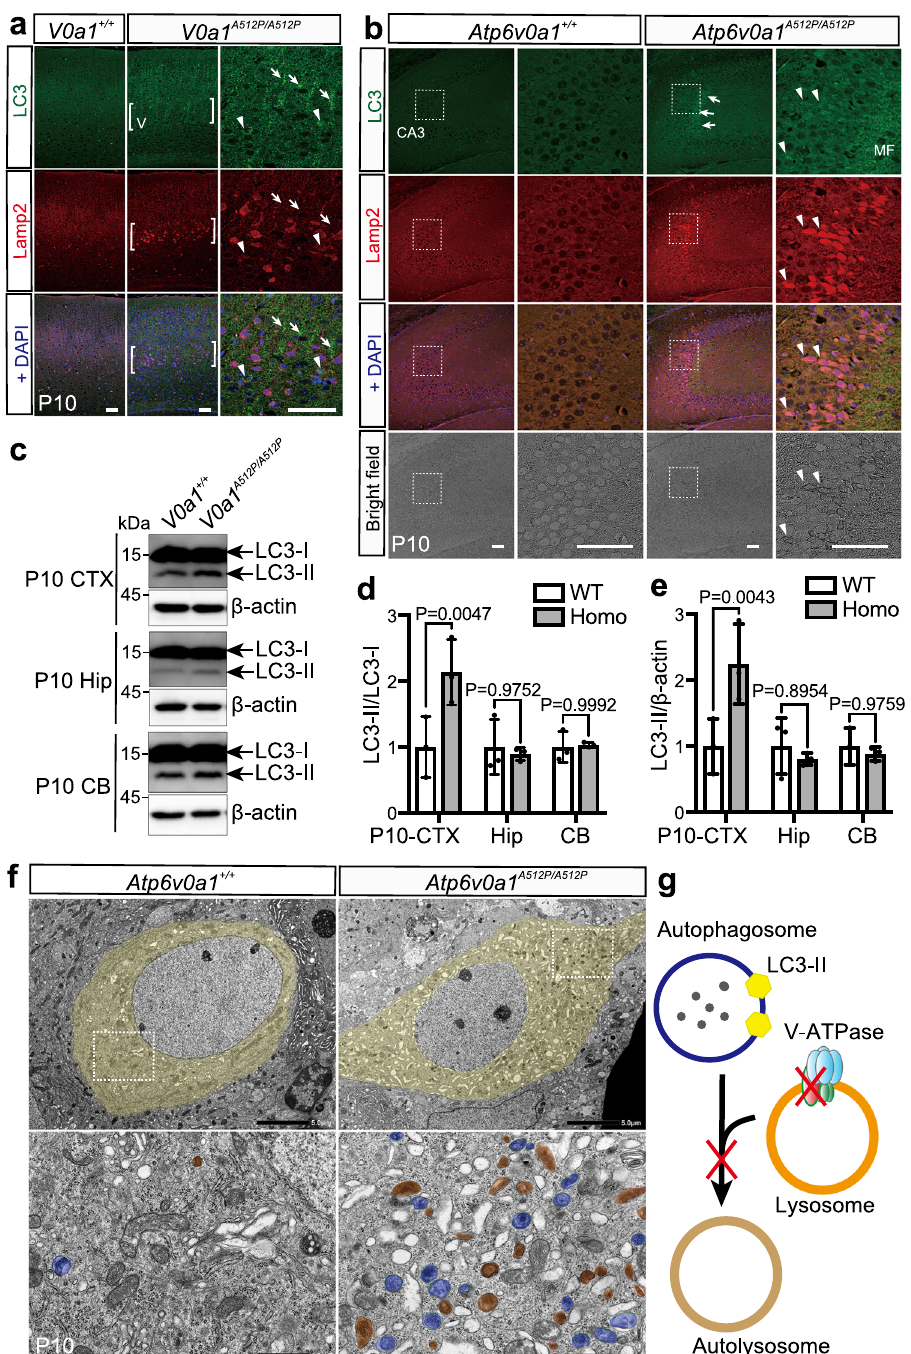
Fig. 7 Accumulation of autophagosomes and lysosomes in the Atp6v0a1 A512P/A512P brain. a , b Immunostaining of the autophagosome maker LC3 and the lysosomal membrane marker Lamp2 in coronal sections of the cortex ( a ) and the hippocampal CA3 region ( b ) of Atp6v0a1 + / + (WT) and Atp6v0a1 A512P/A512P (Homo) pups at P10. LC3 was accumulated in the cell bodies (arrowheads in a ) and neurites (arrows in a ) in layer V of the cortex, and in hippocampal mossy fi bers (arrows in b ) and in the cell bodies of CA3 neurons (arrowheads in b ), in which expanded Lamp2 distributions were also noticeable. In the bright fi eld images in b , healthy CA3 neuronal cells displayed as round-shaped cells with translucent cytoplasm, but abnormal cells with a black boundary were also observed. Scale bars, 50 μ m. c Immunoblot analysis of LC3 levels in the cortex (CTX), hippocampus (Hip), and cerebellum (CB) of Atp6v0a1 + / + and Atp6v0a1 A512P/A512P pups at P10. d , e Quanti fi cation of the band intensity of the immunoblot. The autophagosomal membrane-bound form of LC3, LC3-II, was increased in CTX of Atp6v0a1 A512P/A512P pups. LC3-II intensity was normalized to the LC3-I ( d ) and β -actin ( e ) intensity, and ratios to the average intensity of WT pups were shown. Data represented as mean values±standard deviation of three independent experiments. Two way ANOVA with Sidak ’ s multiple comparisons test was used. f Electron microscopy images in hippocampal CA3 region of Atp6v0a1 + / + and Atp6v0a1 A512P/A512P pups at P10. Neuron of Atp6v0a1 A512P/A512P showed accumulation of autophagosomes (blue) and lysosomes (brown) in the cytoplasmic region (light yellow). Scale bars, 5 μ m (top) and 1 μ m (bottom). g A schematic representation showing that Atp6v0a1 variants cause fusion defect of phagosomes and lysosomes and lead to increased level of LC3-II. Data in a – c are representative of three independent experiments. Electron microscopy data in f are representative of two independent experiments. Source data are provided as a Source data fi le.